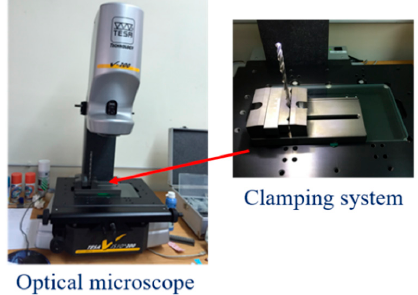
Figure 3. Optical measuring machine and drilling tool clamping system for tool wear measurement.